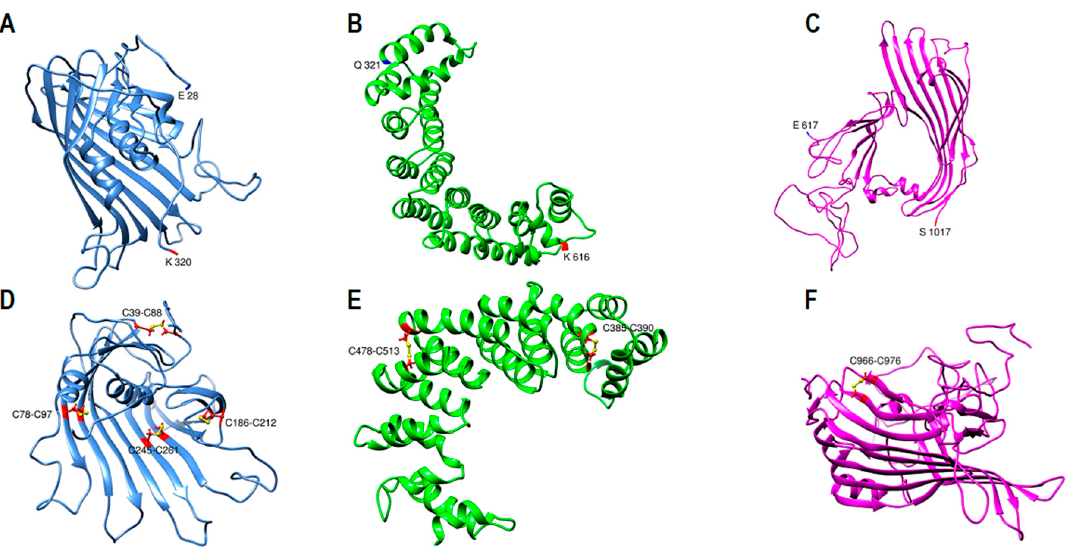
Figure 2. ApoB-100 subunit I domains structures and disulfide bonds. ( A – C ) Ribbon representation of subunit I domains. The N and C termini of each domain are colored in dark blue and red respectively and labeled with a residue number. Domain 1 (blue) is an incomplete β -barrel that extends from E28 residue to K320. Domain 2 (green) is arranged in two layers of α -helices (Q321-K616). Domain 3 (magenta) with two β -sheets on the right and left side and α -helices at the base creates a cavity in the center. ( D – F ) Ribbon representation of subunit I domains with disulfide bonds colored in yellow and cysteine residues colored in red with the ball and stick representation. Four disulfide bonds are located in domain 1 ( D ), two disulfide bonds in domain 2 ( E ), and one disulfide bond in domain 3 ( F ).